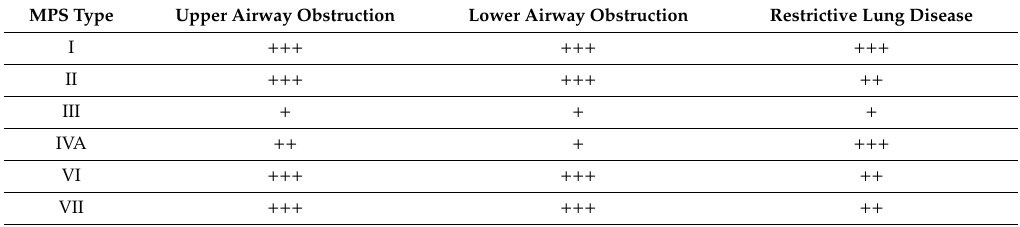
Table 1. Respiratory manifestation in di ff erent types of mucopolysaccharidosis